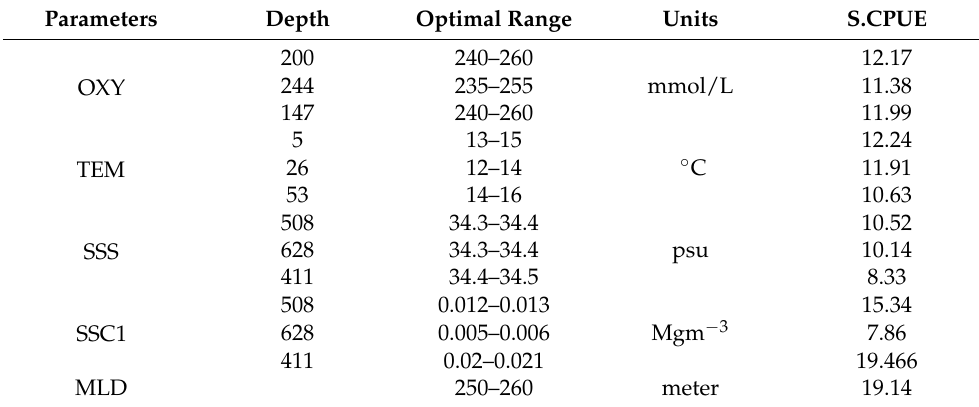
Table 6. Optimal ranges of different environmental parameters in different vertical layers with respect to the highest S.CPUE.